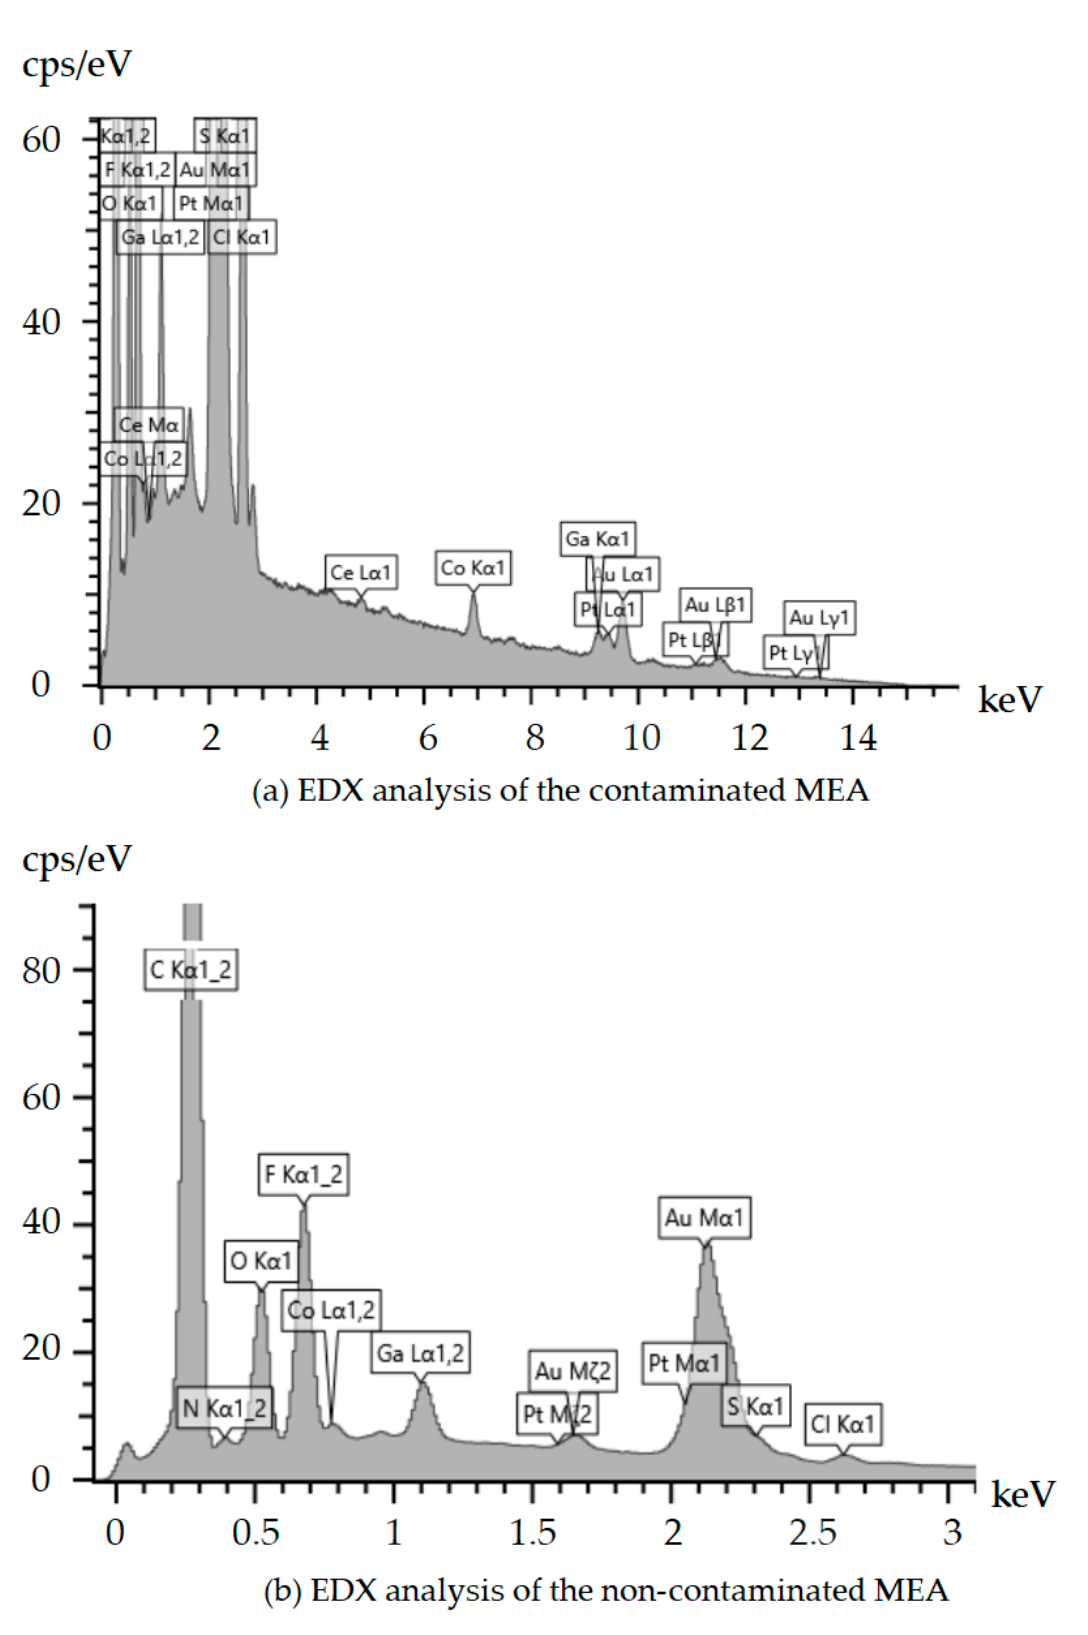
Figure 4. EDX analyses of the contaminated and non-contaminated samples of MEAs: ( a ) EDX analysis of the contaminated MEA and ( b ) EDX analysis of the non-contaminated MEA.